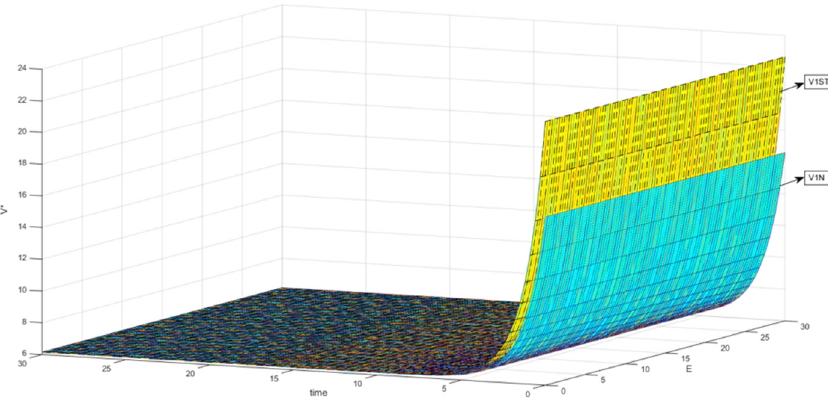
Figure 1: The change of government ’ s optimal bene fi t under noncooperative game and Stackelberg game.